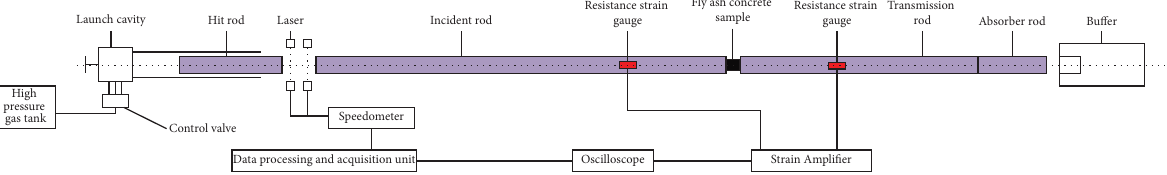
Figure 4: Te split Hopkinson pressure bar test system.